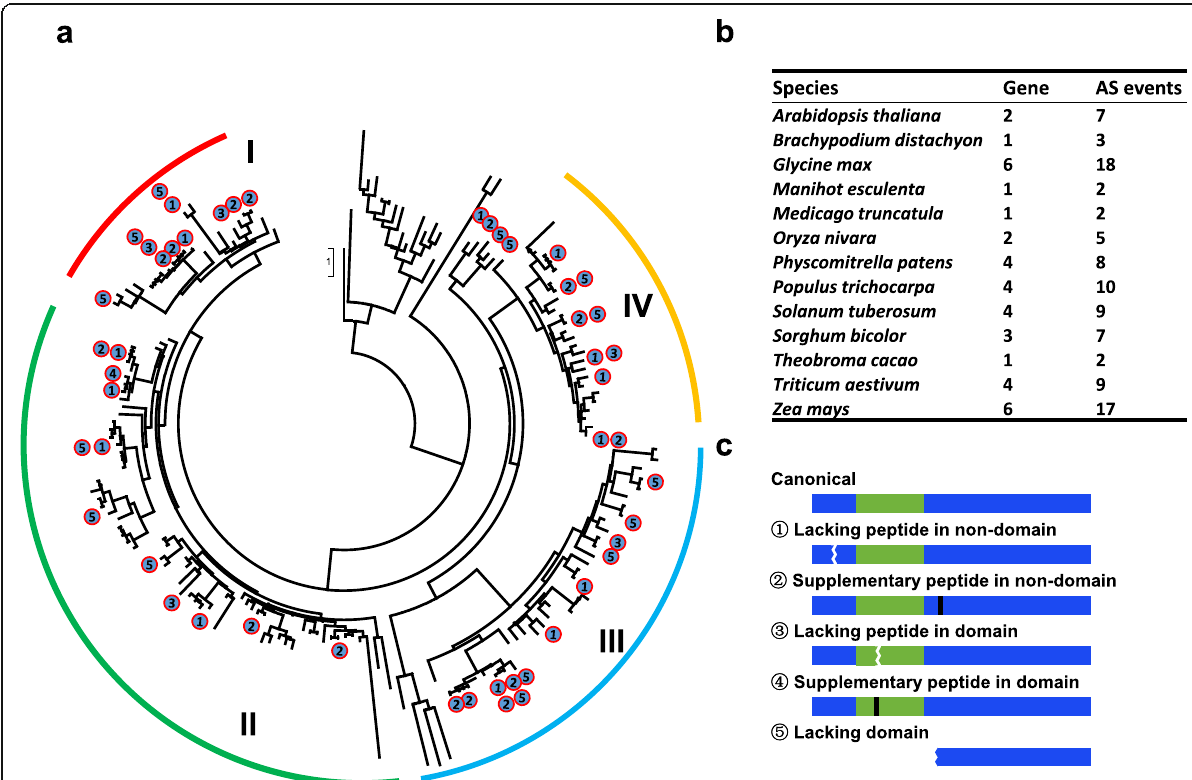
Fig. 4 Alternative splicing of the plant BPA genes. a Alternative splicing events identified in land plant BPAs . Alternative splicing events were mapped onto the BPA phylogenetic tree and labeled with their pattern numbers. ① , lacking peptide in the non-domain region; ② , having supplementary peptide in the non-domain region; ③ , lacking peptide in the domain region; ④ , having supplementary peptide in the domain region; ⑤ , lacking domain region. b Summary of alternative splicing events in selected species. c Alternative splicing patterns detected in this